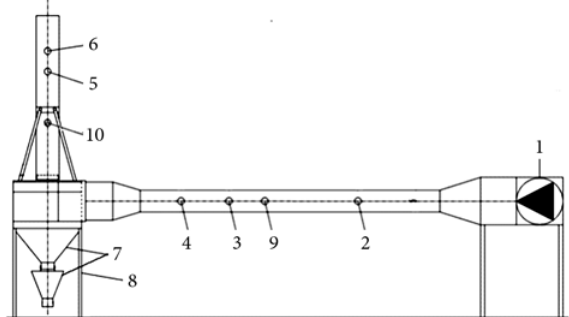
Fig. 1. Experimental stand for one-level 8-channel cyclone: 1 – centrifugal ventilator; 2 – particulates inlet; 3 – place for particulate matter concentration suction before cleaning; 4 – airflow rate measuring place in the inlet duct; 5 – place for particulate matter concentration suction after cleaning; 6 – airflow rate measuring place in the outlet duct; 7 – double hopper; 8 – bearing structure; 9, 10 – nozzles for measuring resistance created by the